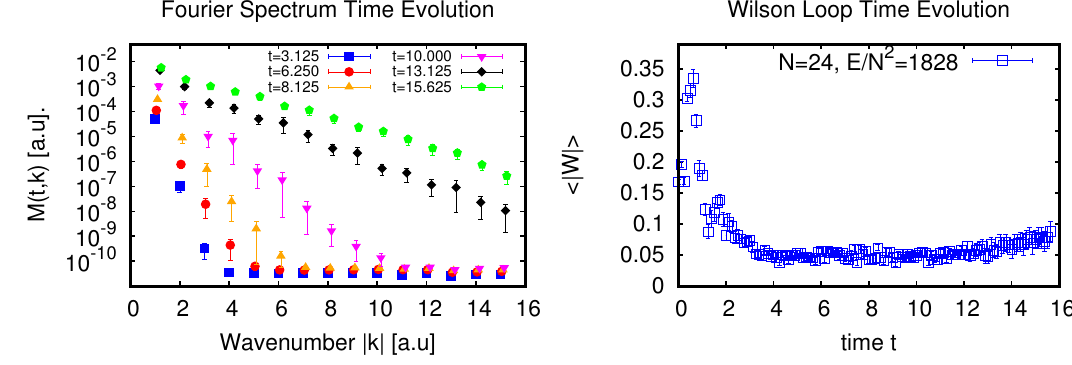
Figure 3 . Left: time-evolution of magnitude M (^ t; ^ k ) of Fourier modes as a function of momentum. At times t (cid:20) 10, M (^ t; ^ k ) only has support in the infrared, while for t (cid:21) 13, pile-up of modes in the UV occurs. Right: time-evolution of absolute Wilson loop expectation value hj W ji . After some initial transient for t (cid:20) 4, hj W ji is approximately constant over time for times 4 (cid:20) t (cid:20) 12. Based on the information from the Fourier modes shown in the left plot, the behavior of hj W ji for t (cid:21) 12 seems to be contaminated by lattice artefacts resulting from mode pile-up in the UV. All simulations for a 32 site lattice with N = 24, (cid:1) t = 0 : 01, and a normalized energy E=N 2 ’ 1828; error bars shown represent statistical error over